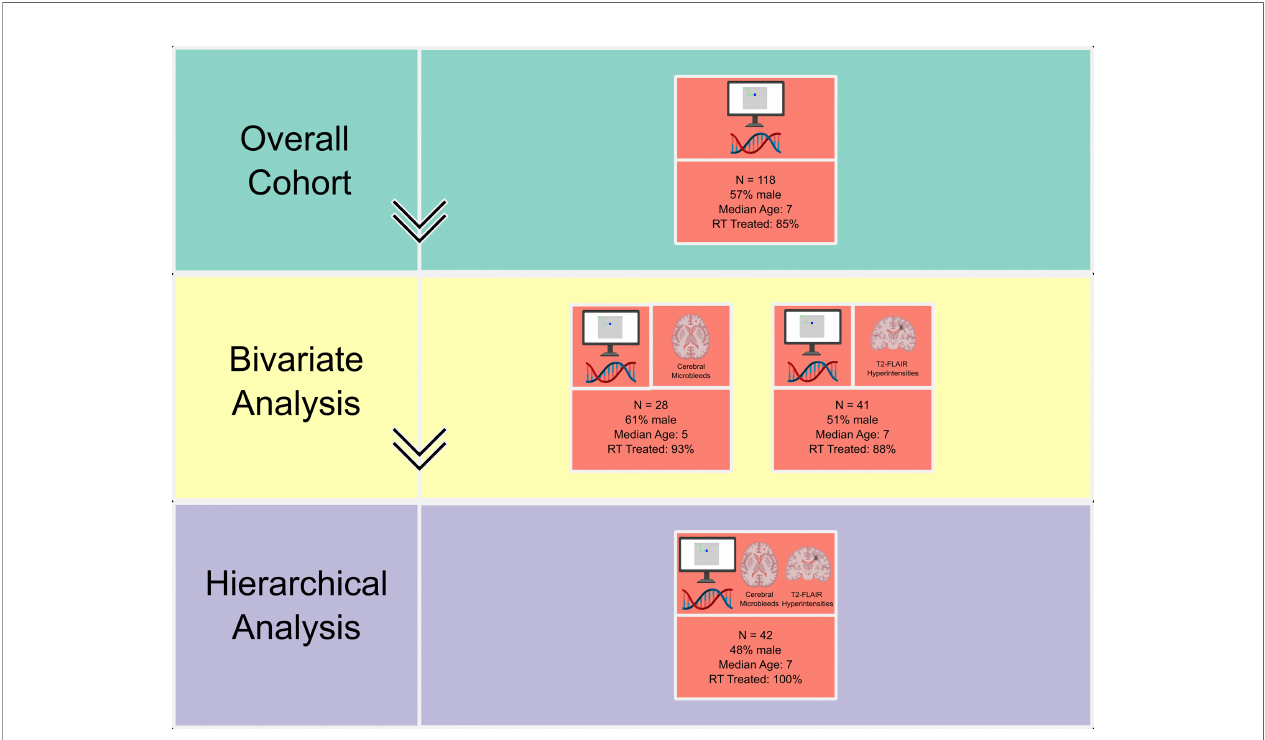
FIGURE 1 | Diagram of modalities investigated and bivariate and multivariate analyses with individual subcohort size and characteristics. Diagram details delineate data type at each level of analysis: neurocognitive assessments (computer screen), candidate gene sequencing (double helix), and imaging (CMBs as axial view, FLAIR WML as coronal view). RT, radiation therapy. Created with BioRender.com.